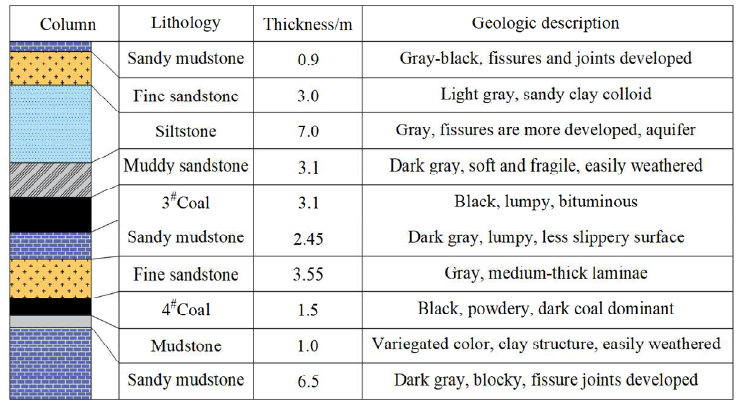
Figure 1. Schematics of mining area roadway layout and roof fall: ( a ) mining area plan; ( b ) original roadway support section; ( c ) diagram of roof fall accident.